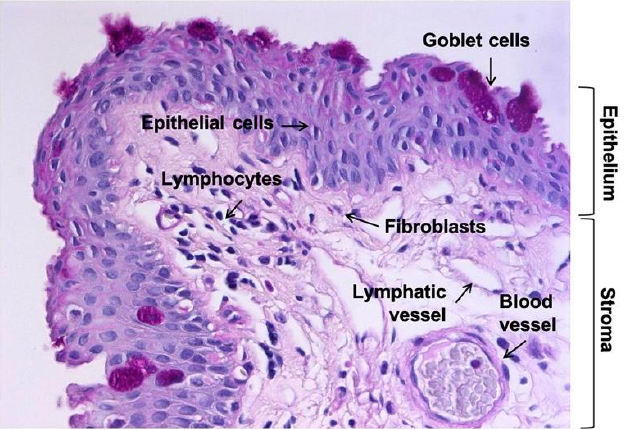
Figure 1. Tissue section of human conjunctiva with periodic acid-Schiff (PAS) staining showing the main cell types present in the epithelium and stroma. Magnification: 200×.